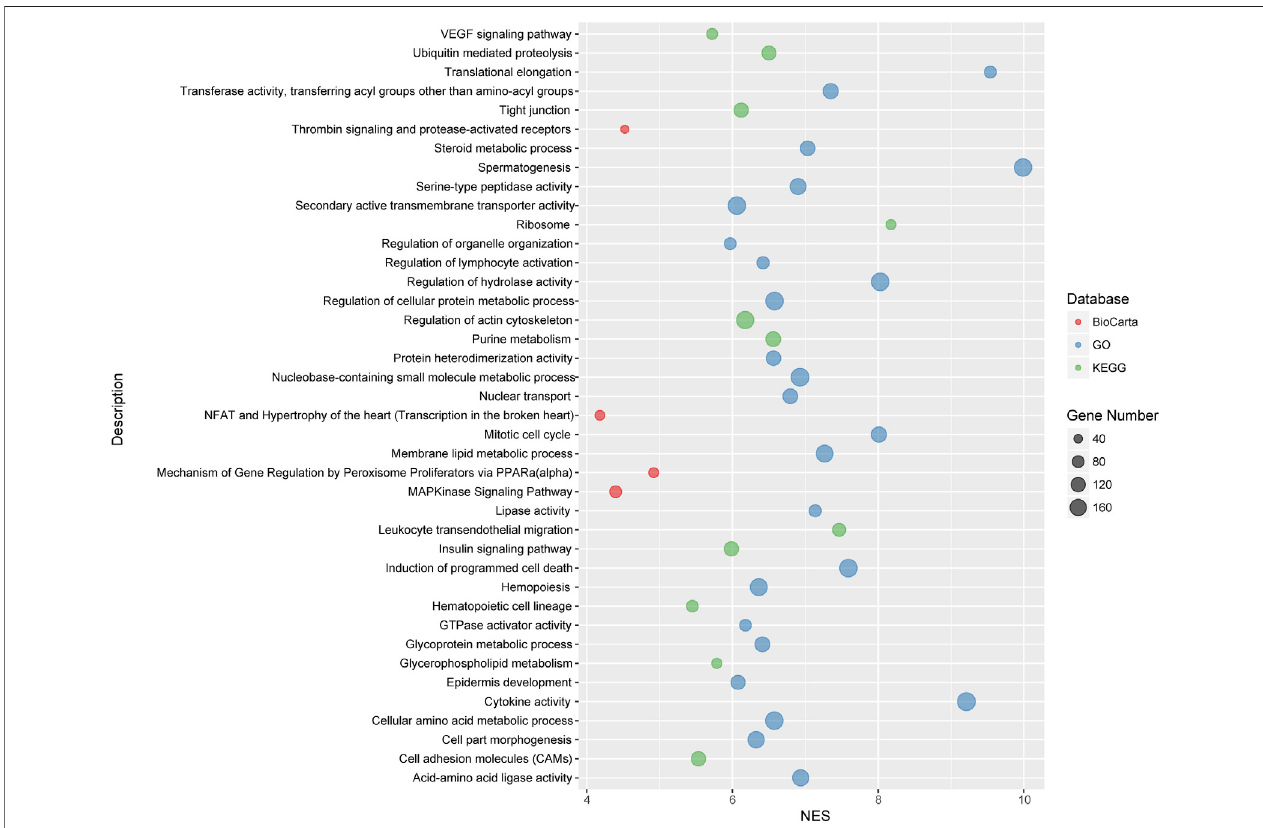
FIGURE 3 | Top signi fi cant pathways/gene sets that associated with cystatin C levels. Results passing multiple hypothesis tests (false-discovery rate (FDR) and or family-wise error rate (FWER) ≤ 0.001) that identi fi ed by pathway association studies were shown in the fi gure. The NES(Wang et al., 2007) denotes normalized enrichment score (ES) which re fl ects the overrepresentation of gene sets at the top of the entire ranking list of genes in the genome.